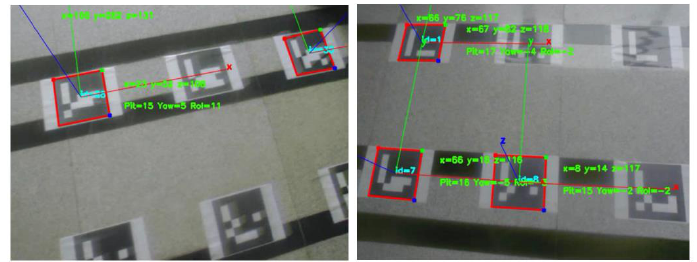
Figure 1. Abnormal Detection Caused by Camera Shake and Reflection.